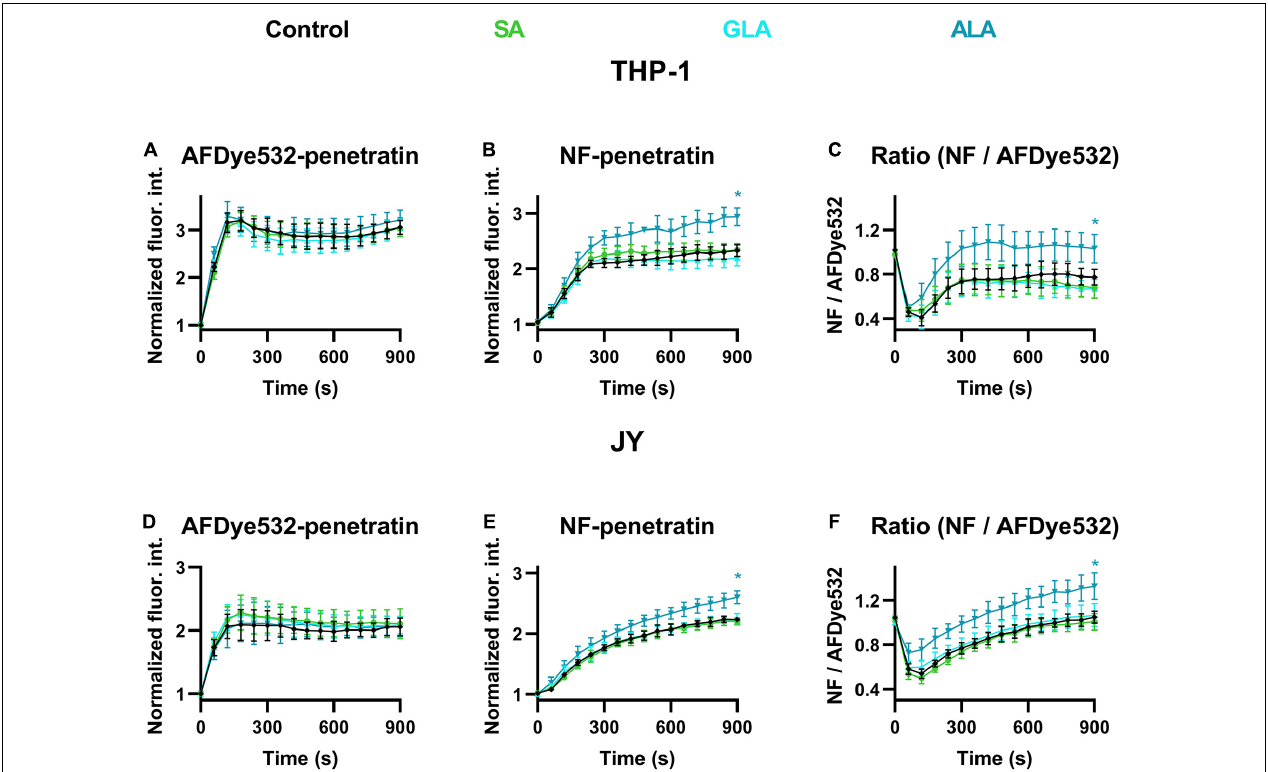
FIGURE 7 | Effects of α -linolenic acid (ALA), γ -linolenic acid (GLA) and stearic acid (SA) on the cellular uptake and endo-lysosomal escape of penetratin. Control THP-1 (A–C) or JY cells (D–F) (black) or those treated with 50 µ M ALA (blue), GLA (cyan) or SA (green) for 48 h were incubated at 37 ◦ C in the continuous presence of 5 µ M of AFDye532- and 5 µ M of NF-labeled penetratin. Fluorescence intensities of individual cells were measured using time-correlated flow cytometry. After gating out debris and non-viable cells, the average fluorescence intensities of AFDye532 (A,D) , NF (B,E) and their ratios (C,F) were calculated in 10 s-periods and normalized to minimal values using data from five independent experiments per sample. Every 6th data point ( ± SD) was plotted as a function of time. Asterisks (*) indicate significant differences compared to control samples at 900 s ( p < 0.05, ANOVA followed by Tukey’s HSD